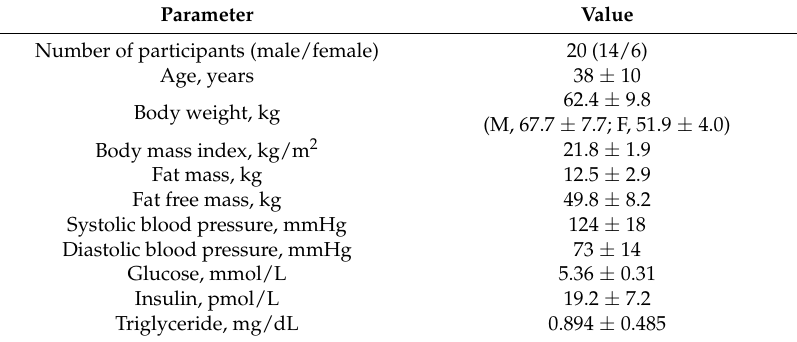
Figure 1. The study protocol. Table 1. Characteristics of the participants.